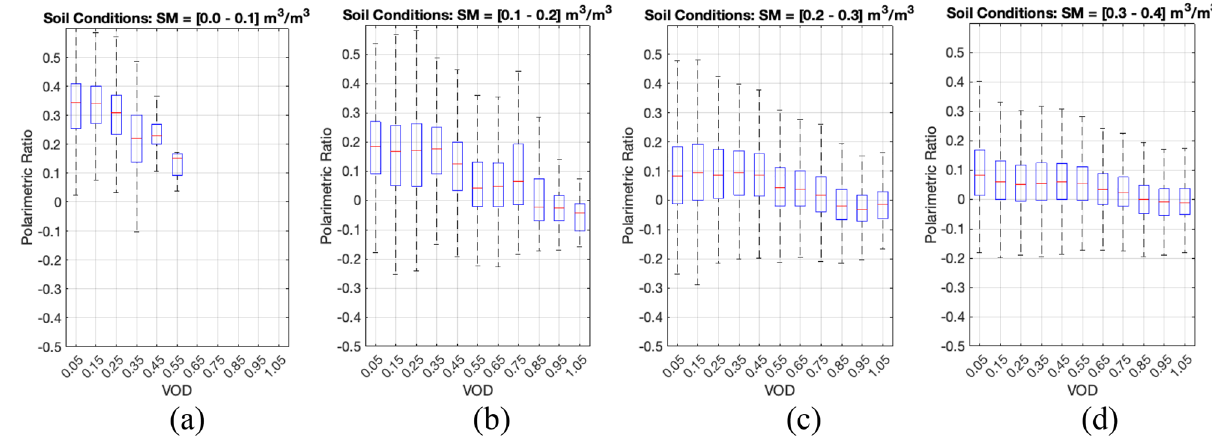
Figure 4. Sensitivity of SMAP GNSS-R dataset gridded 9 km to VOD variations of 0.1 for a range of SM: ( a ) [0.0 – 0.1] m 3 /m 3 , ( b ) [0.1 – 0.2] m 3 /m 3 , ( c ) [0.2 – 0.3] m 3 /m 3 , and ( d ) [0.3 – 0.4] m 3 /m 3 . All figures made with Matlab R2021b (version 9.11.0.1809720, URL: https:// www. mathw orks. com/ produ cts/ new_ produ cts/ relea se202 1b.